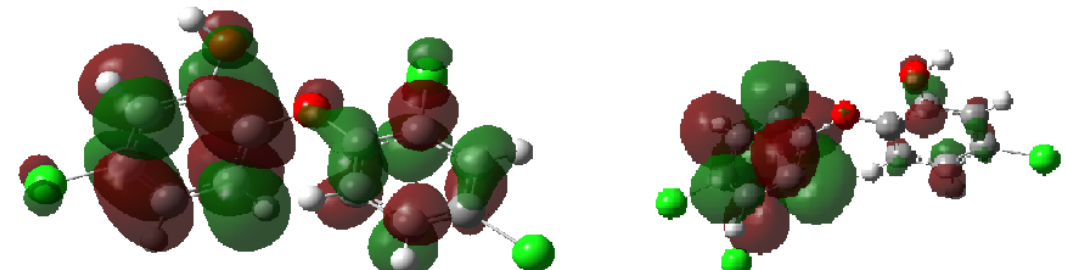
Fig. 3. HOMO and LUMO patterns in gas and water phases by B3LYP/6-311++G(2d,2p)